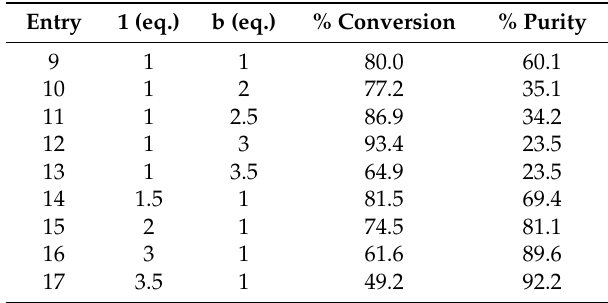
Table 2. Investigation of stoichiometric ratio of the reagents on conversion and purity of compound 1b . Entry 1 (eq.) b (eq.) % Conversion % Purity 9 1 1